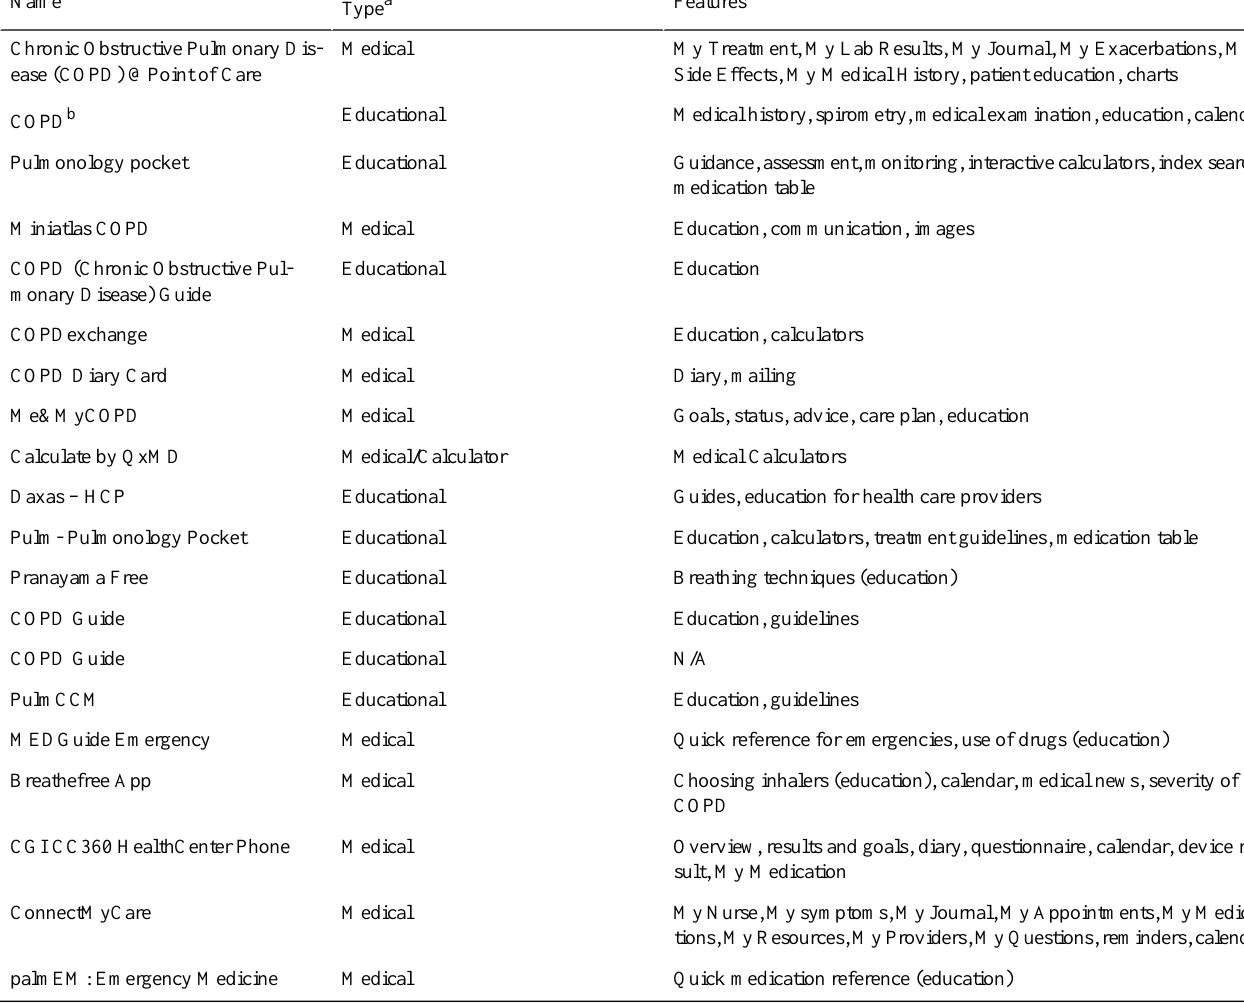
Table 1. List of mobile apps and their